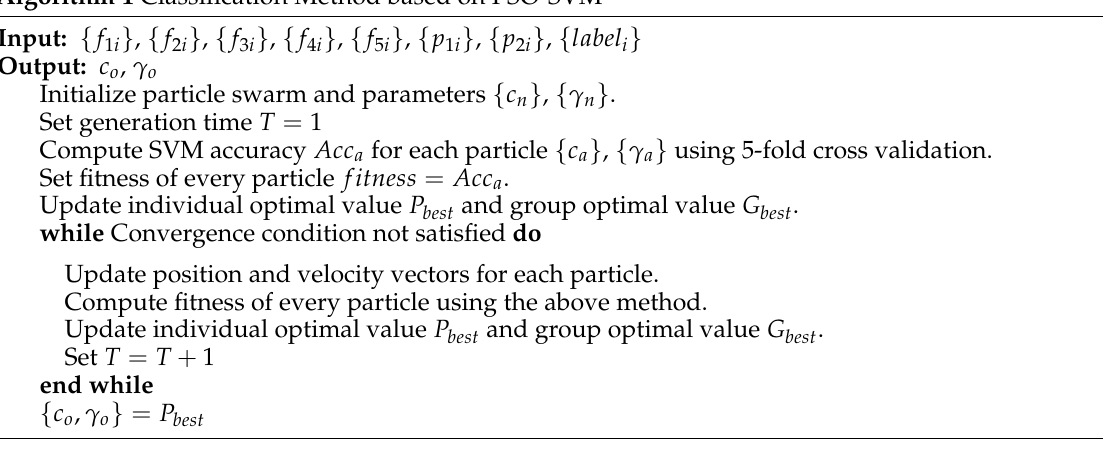
Algorithm 1 Classification Method based on